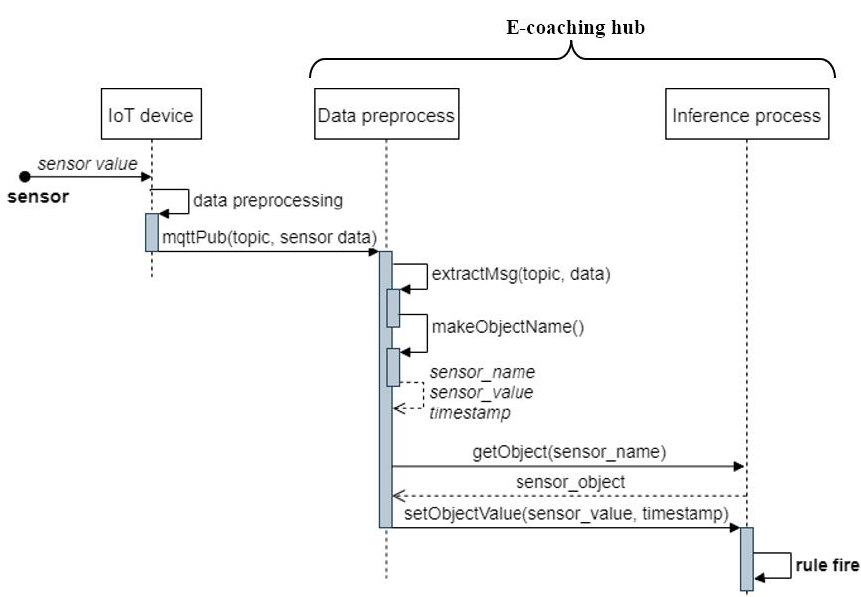
Figure 7. Sequence diagram of the detailed processes for each step of an ADL evaluation